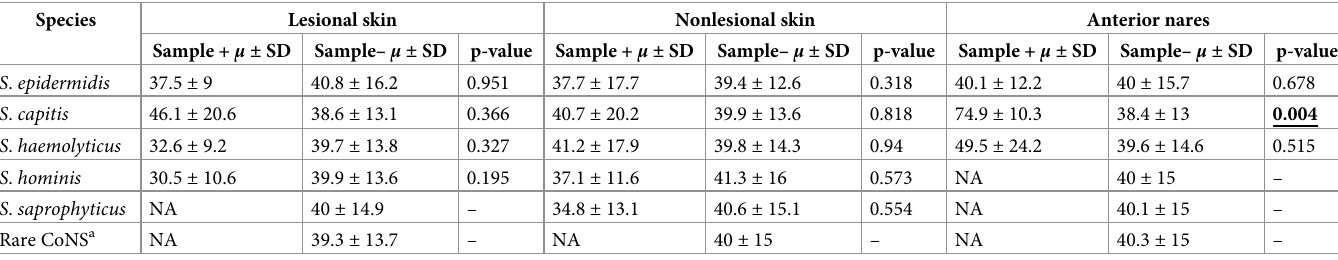
NA represents observations that are too few for mean and standard deviation calculation. Sample +, CoNS present; Sample -, CoNS absent; μ , mean; SD, standard deviation. Underlined bold text indicates statistical significance. P-values were determined using the Wilcoxon rank-sum test. a Rare CoNS include S . caprae , S . cohnii , S . equorum , S . lentus , S . lugdunensis , S . nepalensis , S . pasteuri , S . sciuri , S . succinus and S . warneri